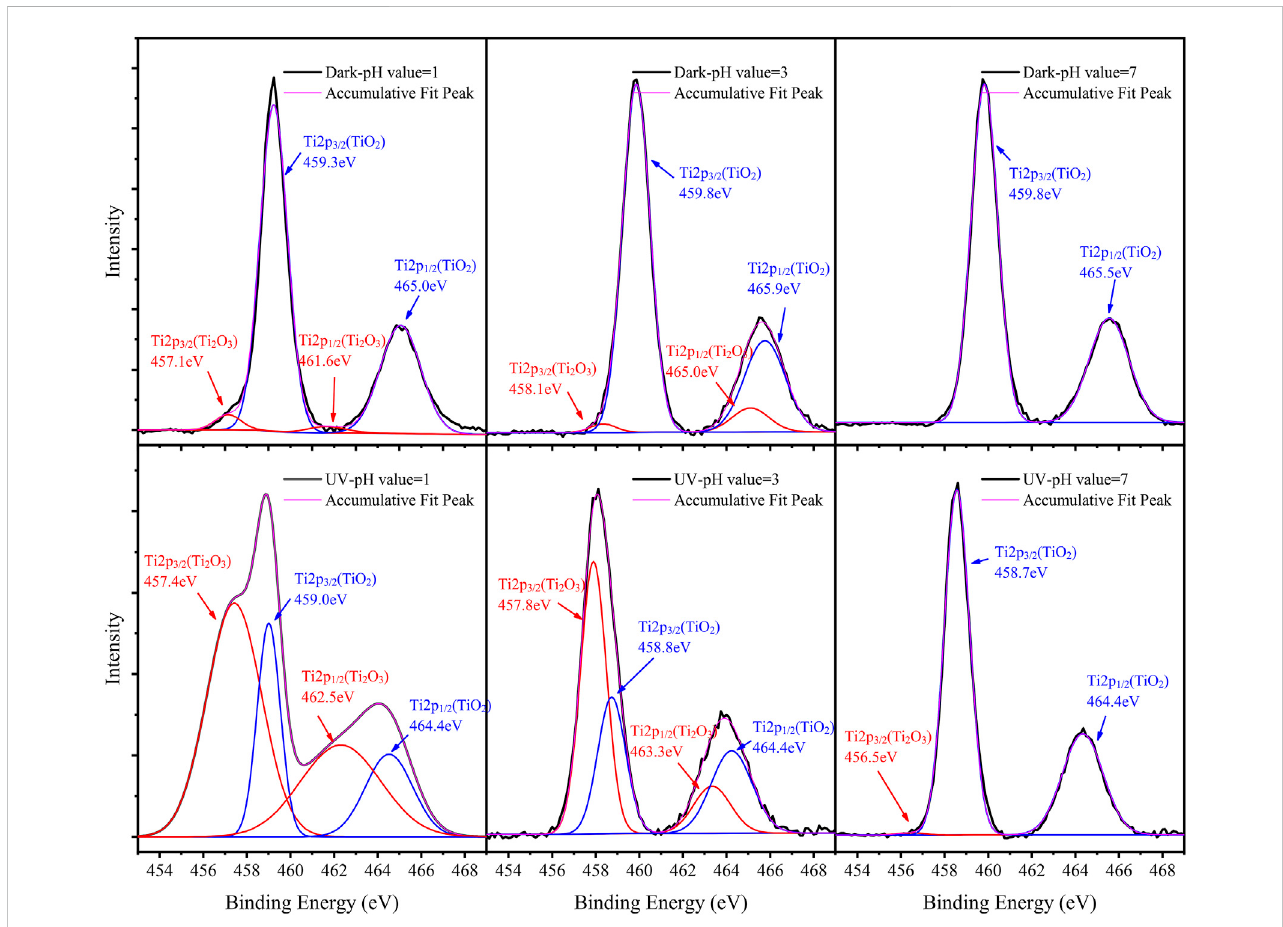
FIGURE 9 XPS results of Ti 2p of wear scars on TiO 2 surfaces after running-in in different pH values (Hirano and Shinjo, 1990; Dienwiebel et al., 2005; Tian et al., 2022) with and without ultraviolet illumination.